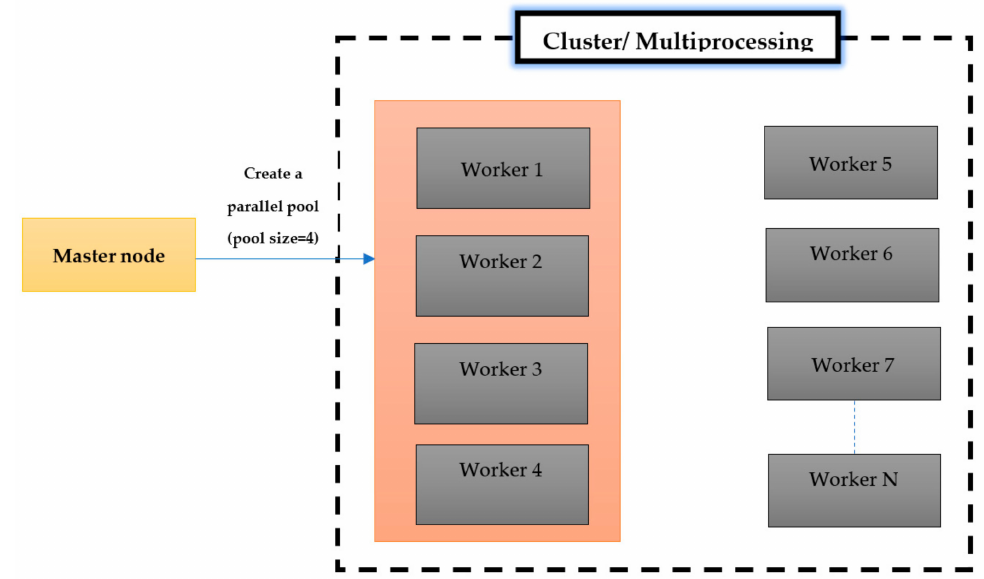
Figure 3. MatlabPool (pool size =